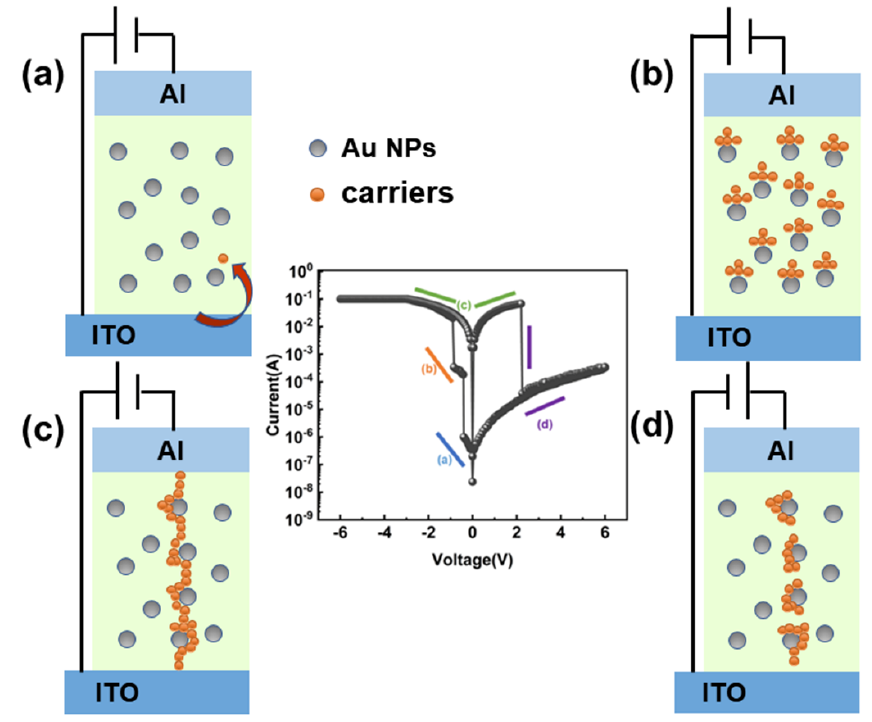
Figure 11. Diagram of state switching of ITO/PF-BBO/Au/Al.